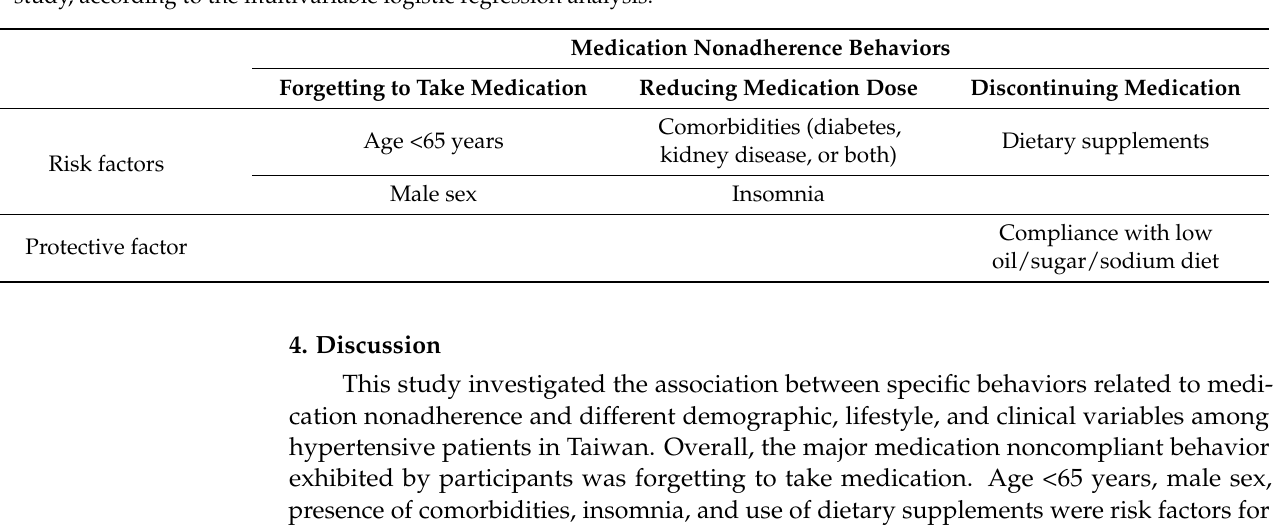
Table 4. Summary of factors associated with specific behaviors of nonadherence to antihypertensive medication in this study, according to the multivariable logistic regression